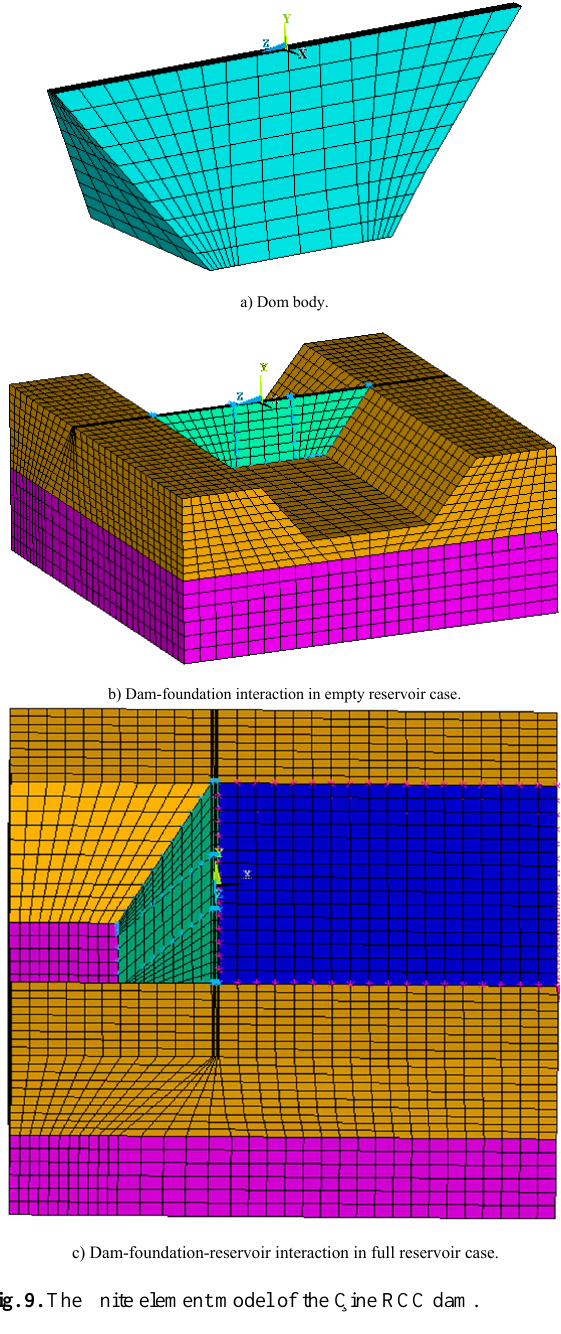
Fig. 9. The finite element model of the Çine RCC dam.